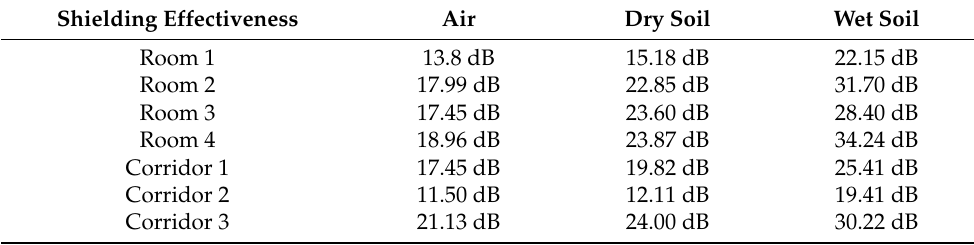
Table 5. Measurement results of natural shielding effectiveness against E1 Pulse.